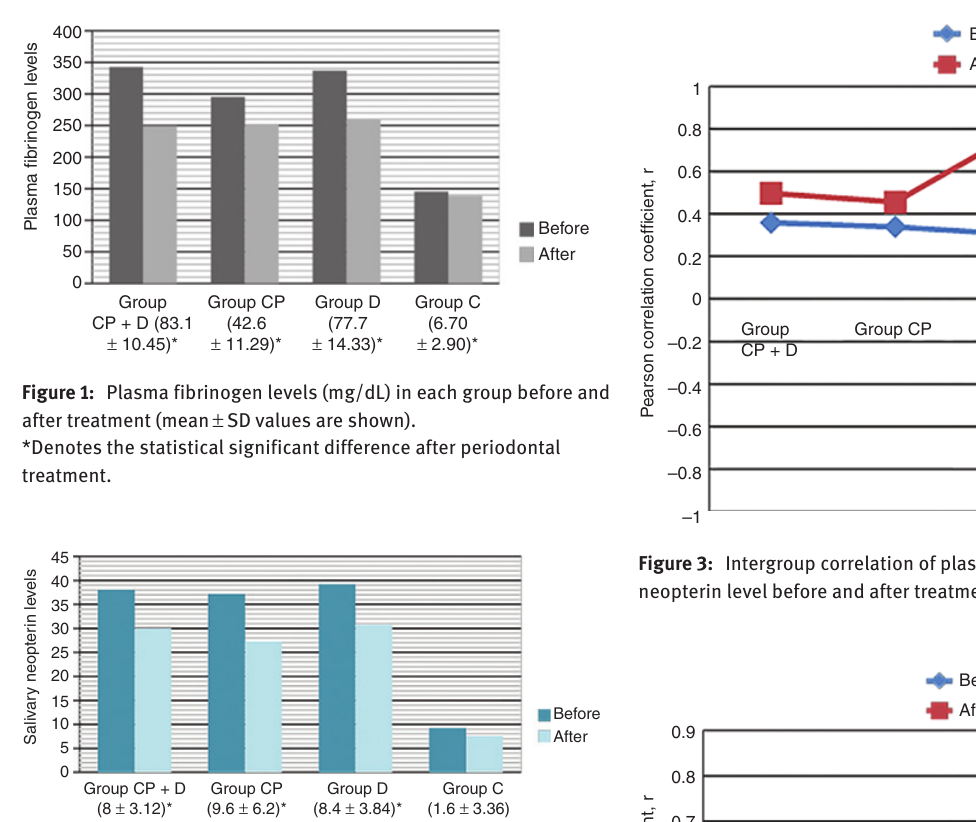
Figure 2: Salivary neopterin levels (nmol/L) in each group before and after treatment (mean ± SD values are shown).